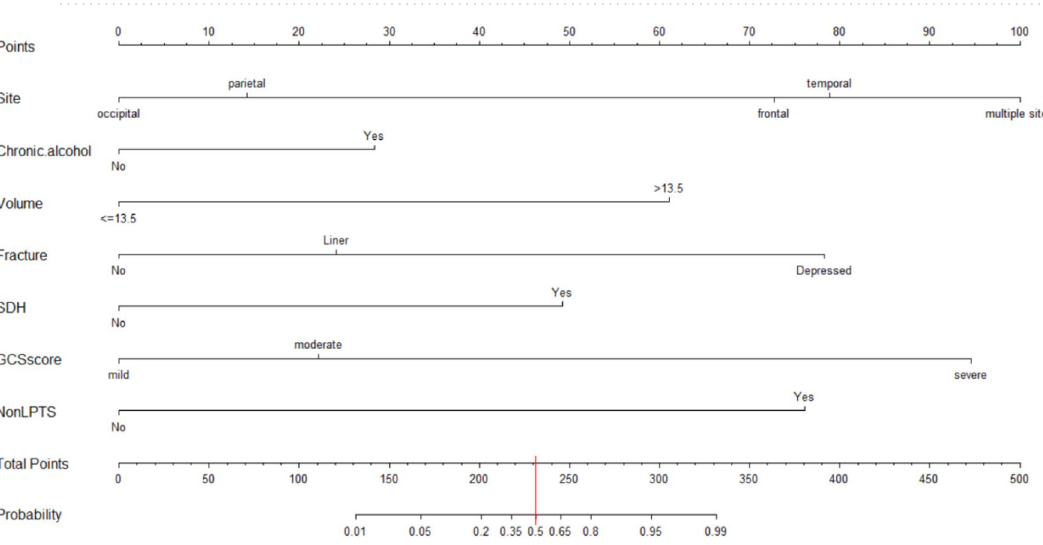
Figure 4. Nomogram model. SDH subdural hematoma, GCS glasgow coma scale, LPTS late post-traumatic